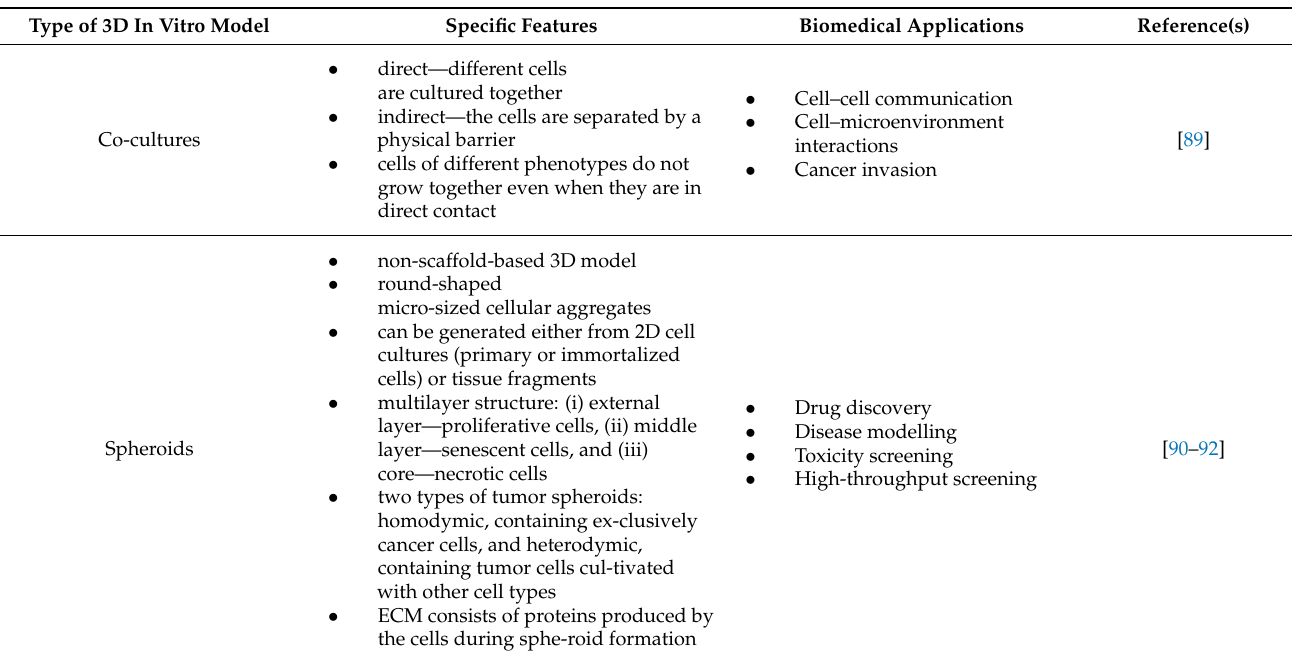
Table 3. A summary characterization of 3D in vitro